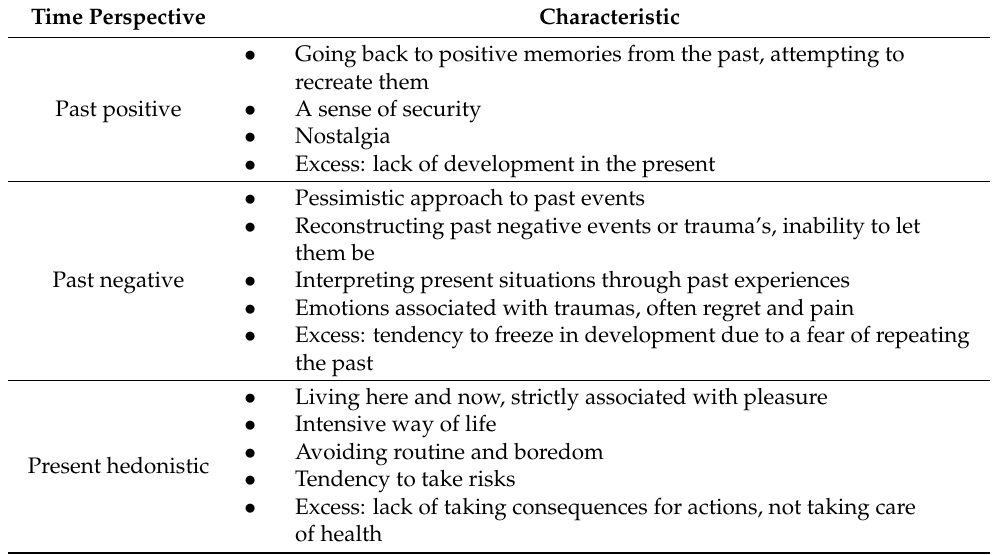
Table 1. The five temporal perspective and their characteristics, according to Zimbardo Time Perspec- tive